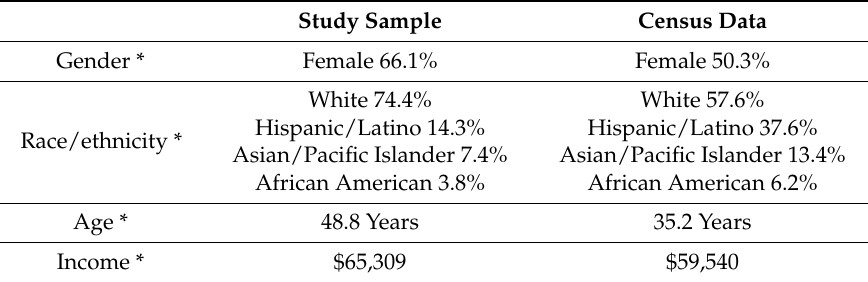
Table 1. Demographic Characteristics of the Sample ( N = 2052) Compared to 2010 CA Census